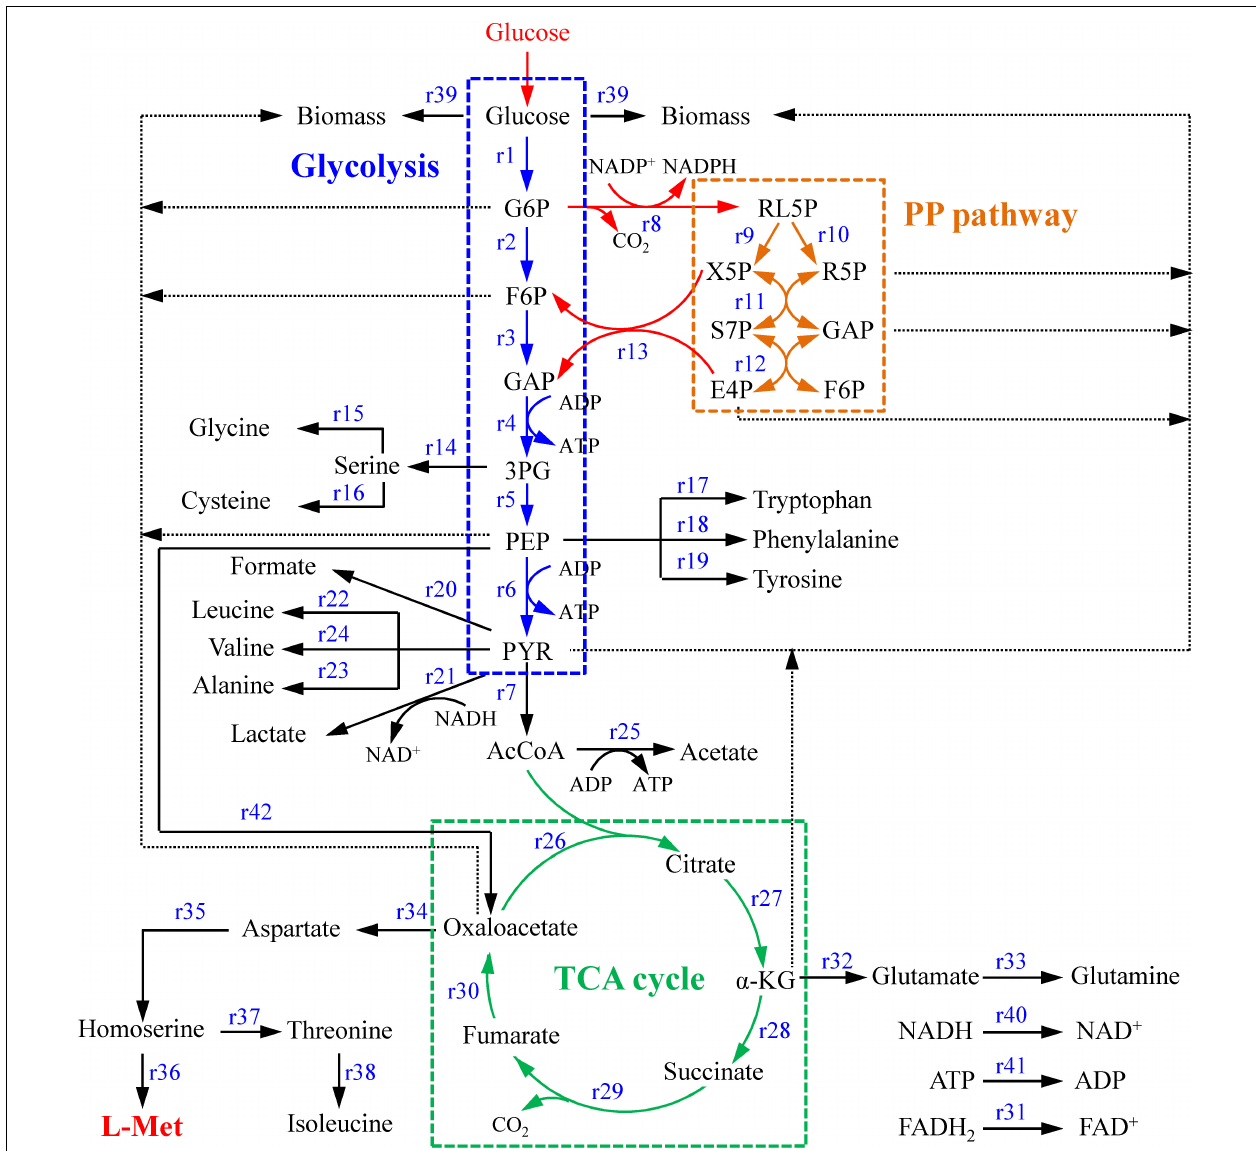
FIGURE 1 | The central metabolism network of E. coli W3110-BL. Abbreviations: G6P, glucose-6-phosphate; F6P, 6-phosphate fructose; GAP, glyceraldehyde 3-phosphate; 3PG, 3-phosphoglycerate; PEP, phosphoenolpyruvate; PYK, pyruvate; AcCoA, acetyl coenzyme A; α -KG, α -ketoglutarate; RL5P, ribulose-5-phosphate; X5P, xylulose-5-phosphate; R5P, ribose-5-phosphate; E4P, erythrose-4-phosphate; S7P, sedoheptulose-7-phosphate.